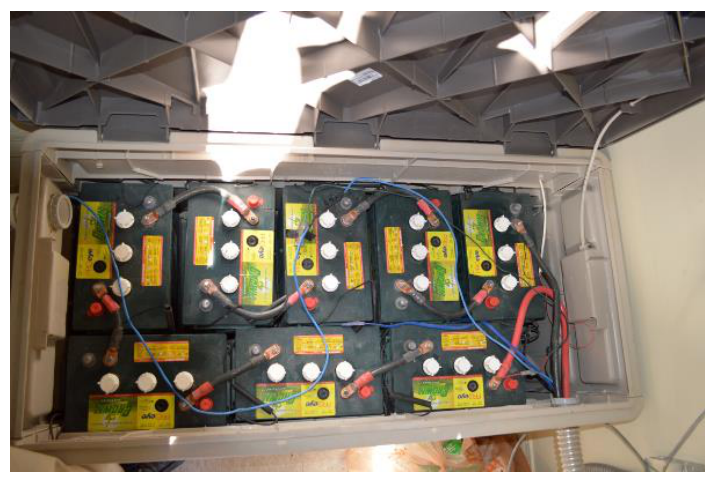
Figure 4. Battery storage for the hybrid DER.